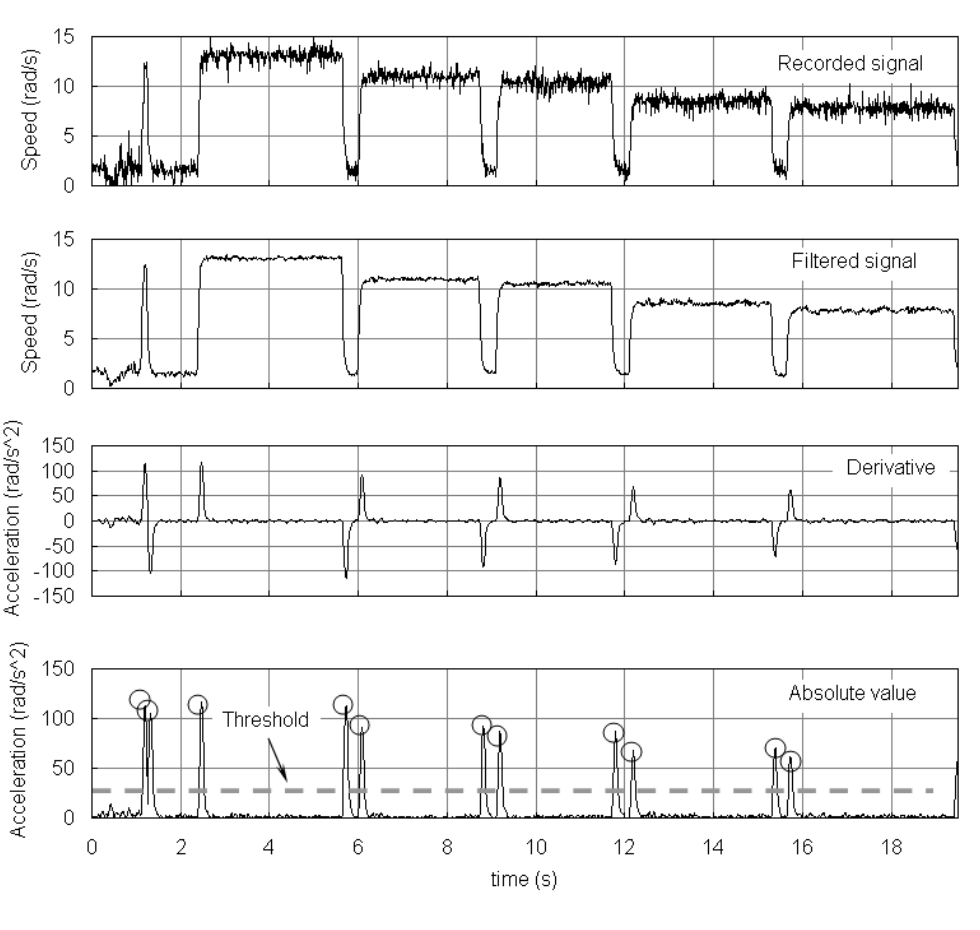
Figure 5. Processing stages of the tool speed